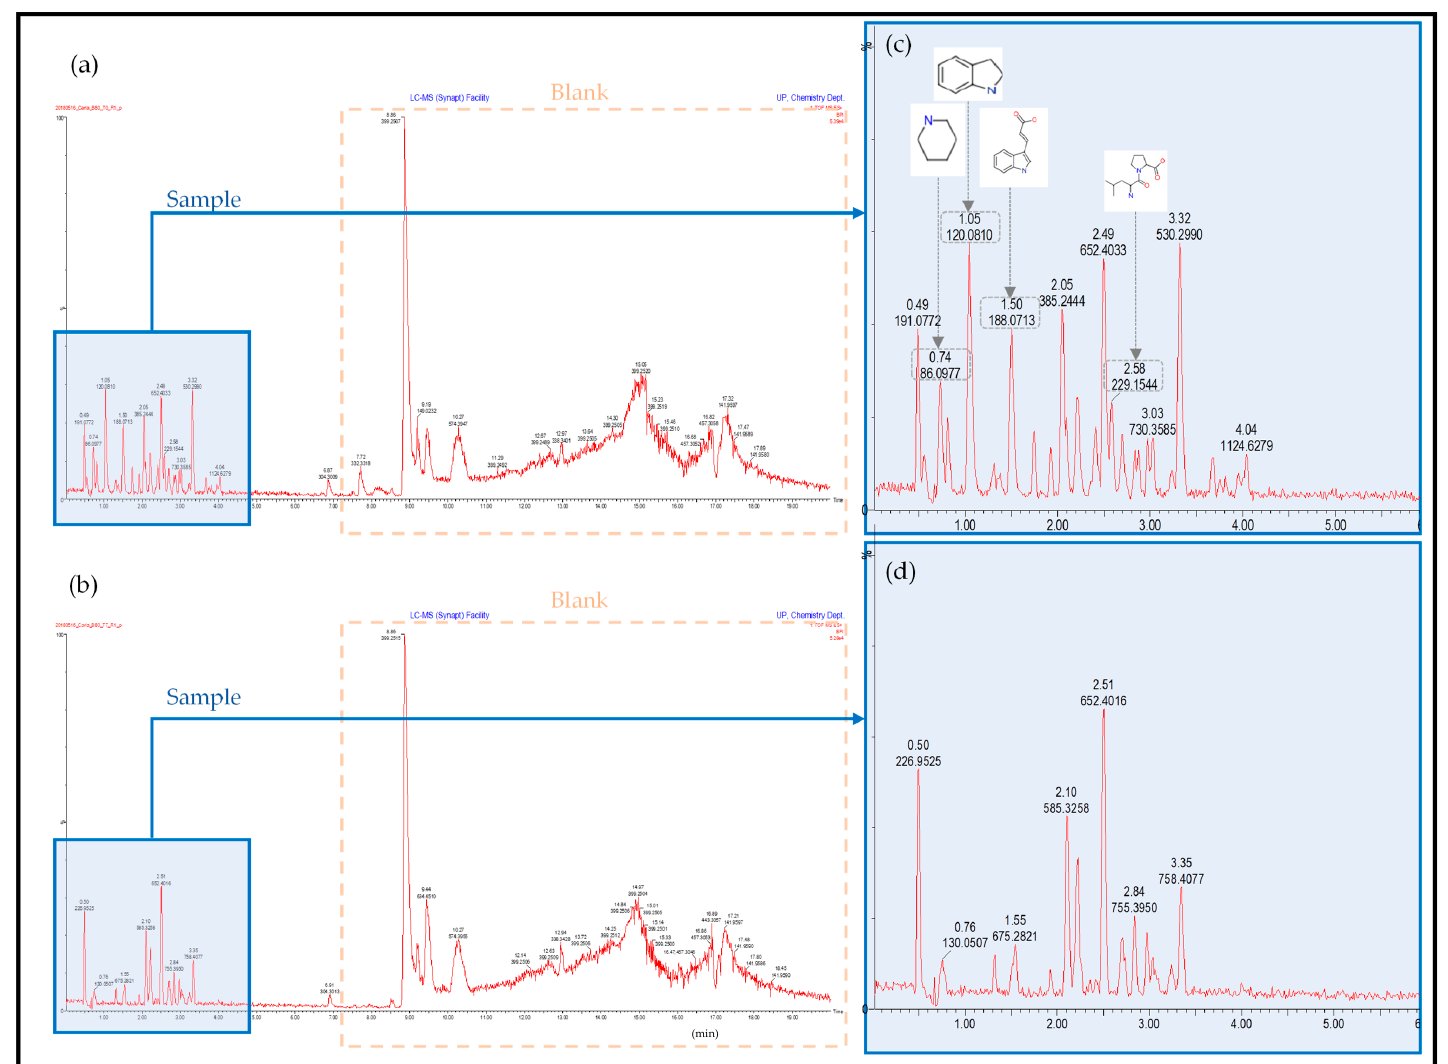
Figure 2. UPLC-HDMS chromatographs for 80 LB sample at 0 h ( a ), after 33 h ( b ), an enlarged image of the sample at 0 h ( c ) and 33 h ( d